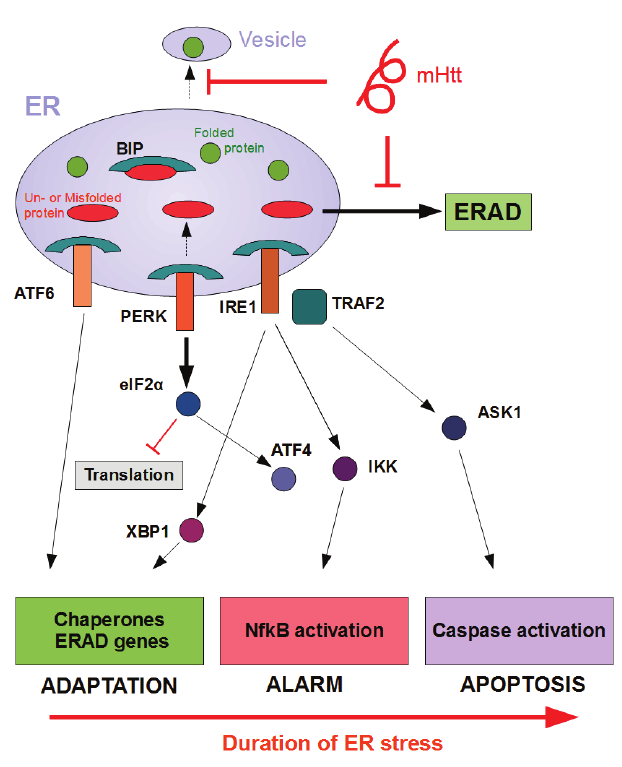
Figure 1. Phases of UPR activation and putative triggering of ER stress by mHTT. One explanation for how UPR sensors IRE1, PERK and ATF6 are activated is through detachment of chaperone BiP in the presence of excess un- or misfolded protein. This leads subsequently to the execution of a series of molecular processes with different effector functions 17 . As an adaptive response, the UPR up-regulates transcription of chaperones, temporarily attenuates new translation, and activates protein degradation via the proteasome. Persistent levels of ER stress, however, may trigger inflammatory pathways as an alarm signal in addition to caspase activation, leading ultimately to the induction of apoptosis. Mutant Huntingtin (mHTT) might provoke ER stress through interference with different processes such as vesicular transport or ER-associated degradation (ERAD) resulting in accumulation of (misfolded) protein in the